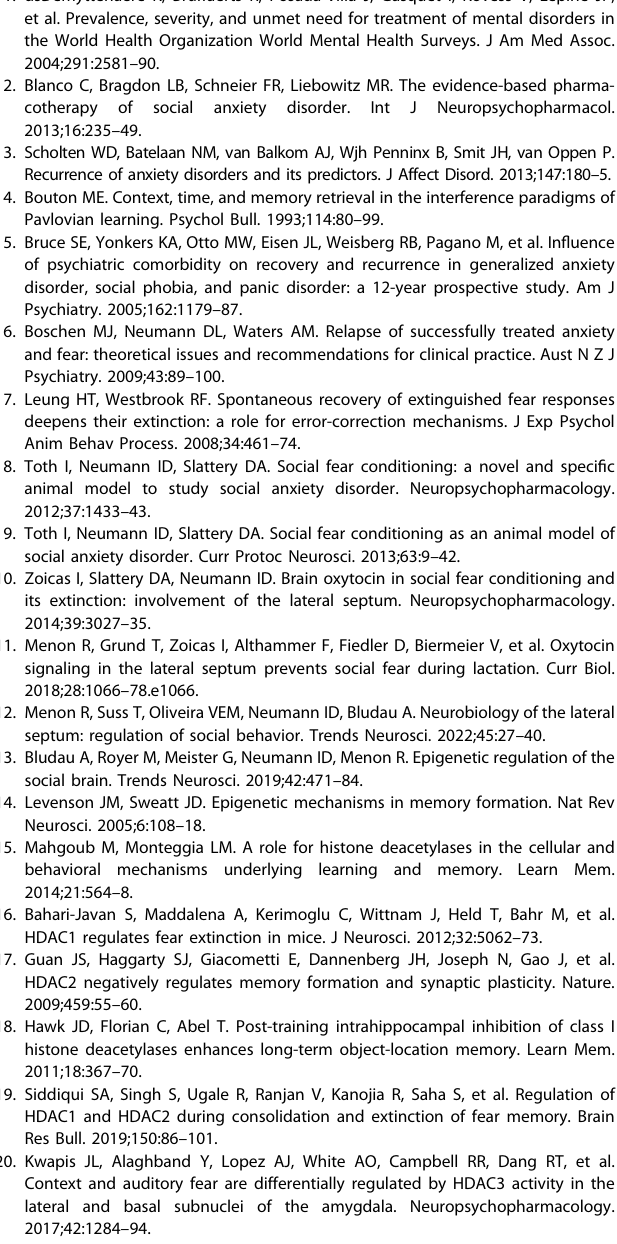
Fig. 5 Inhibition of HDAC1 or activation of GABA-A receptors within the lateral septum (LS) enhances long-lasting social fear extinction. Schematic representation of LS, including pharmacological interventions. Scalebar indicates 200 µm and infusions within the highlighted area were considered as correct cannula placements ( A ). Inhibition of HDAC1 ( B – D ) and activation of GABA-A receptors ( E – G ) facilitated long- lasting social fear extinction. Conditioned (SFC + ) and unconditioned (SFC − ) mice were bilaterally infused with vehicle (Veh; 0.5% DMSO in sterile Ringer; 0.2 µl/hemisphere) or MS275 (375 ng/0.2 µl/hemisphere) ( B – D ) 120 min prior to extinction or in a separate cohort of mice with Veh (0.5% DMSO in sterile Ringer; 0.2 µl/hemisphere) or Muscimol (Muc; 0.2 µg/0.2 µl/hemisphere) 10 min prior to social fear extinction. Number of CS-US pairings of SFC + mice during social fear acquisition on day 1 ( B , E ). The percentage of investigation time of three non-social (empty cages) and six social (cage with a conspeci fi c) stimuli was measured during social fear extinction (day 2; C , F ) and social fear extinction recall (day 32; D , G ) in SFC − and SFC + mice. Data represent mean CS-US pairings ± SEM ( B , E ) or mean percentage investigation time ± SEM ( C , D and F , G ). * P < 0.05 for SFC + /Veh vs. SFC + /MS275 ( C , D ); * P < 0.05 for SFC + /Veh vs. SFC + /Muc ( F , G